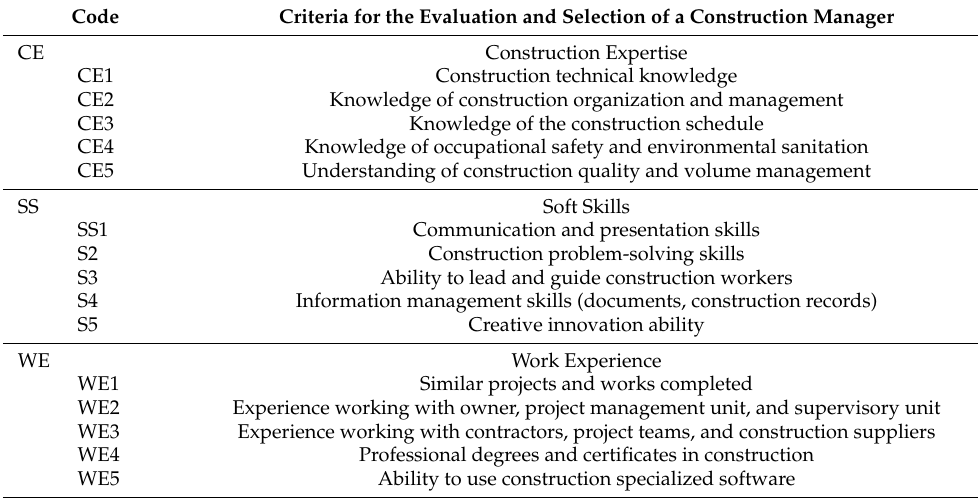
Table 1. Criteria for the evaluation and selection of a construction